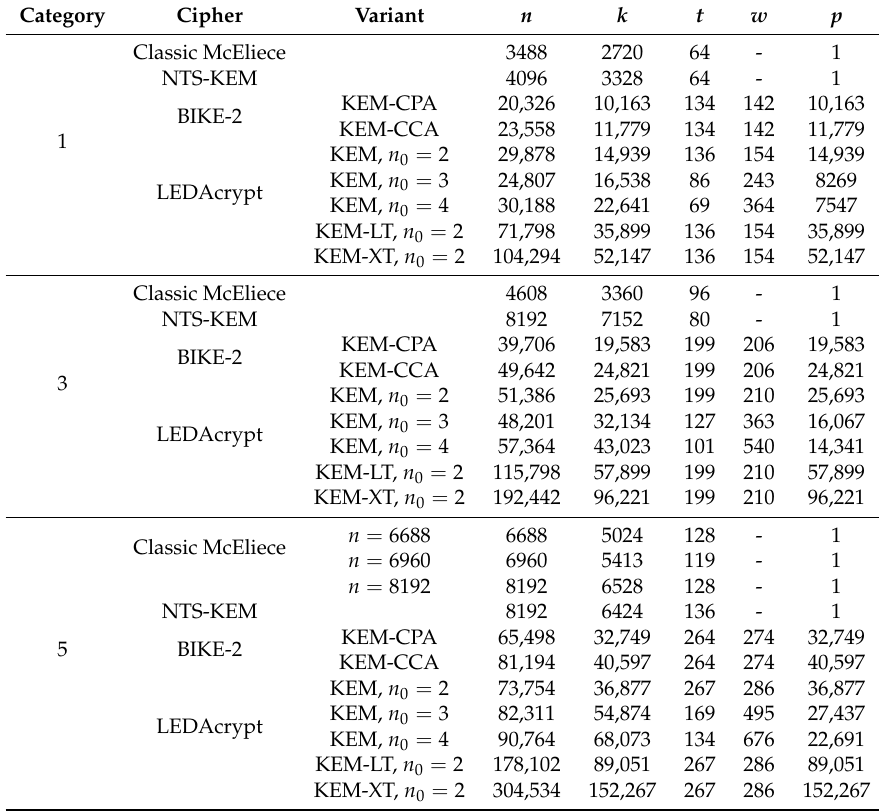
Table 2. Summary of the code parameters for the second round submissions: code length n , code redundancy n − k = r , and number of errors expected to be corrected t